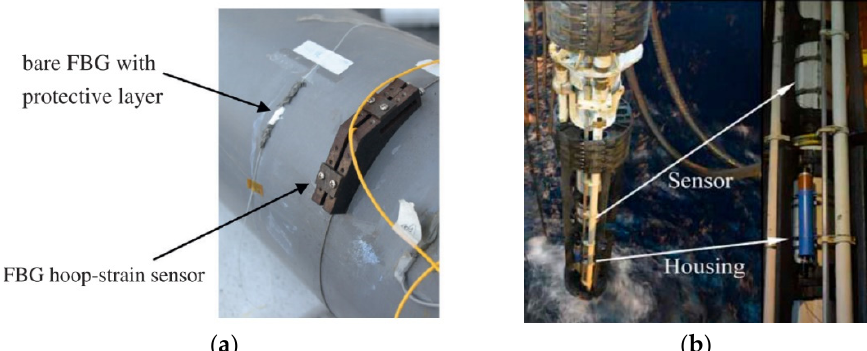
Figure 12. ( a ) Photo of FBG hoop strain sensors wrapping around a pipe (Reprinted from Reference [84] with permission from Elsevier); ( b ) Field demonstration of FBG-based sensors to monitor the riser stress for subsea drilling and operations [88].